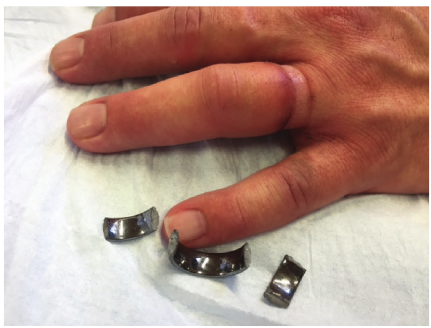
Figure 2: Patient’s hand and ring after removing the